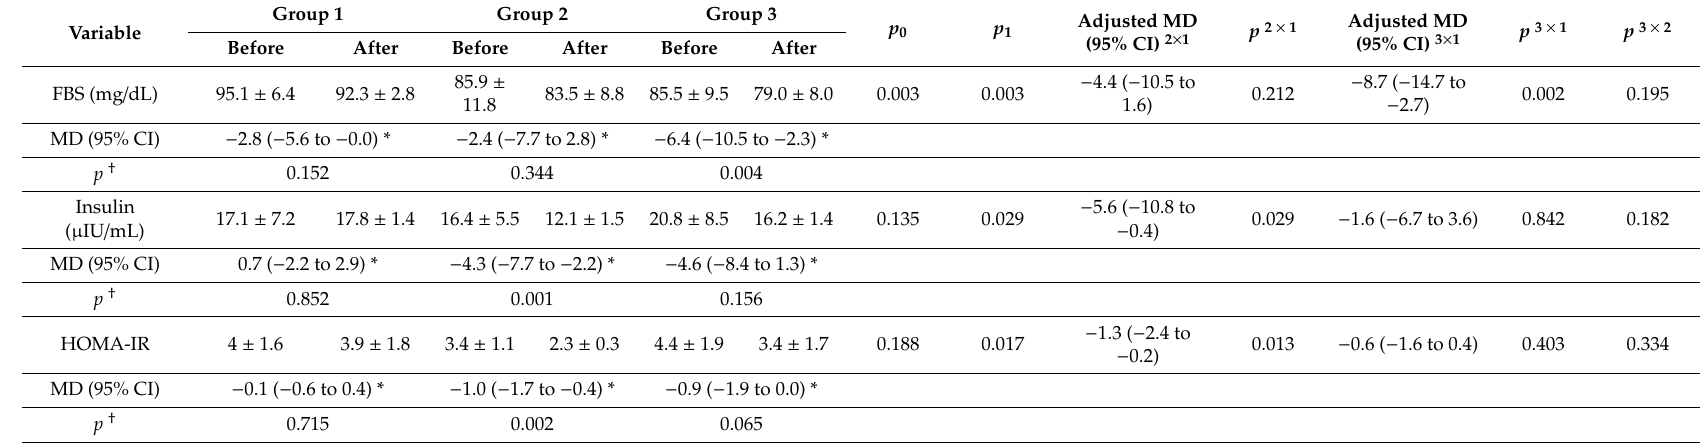
Table 5. Comparison of mean ± SD serum levels of FBS, insulin, and HOMA-IR in participants receiving CC, herbal mixture, CC along with herbal mixture. Group 1 Group 2 Variable After Before After Before